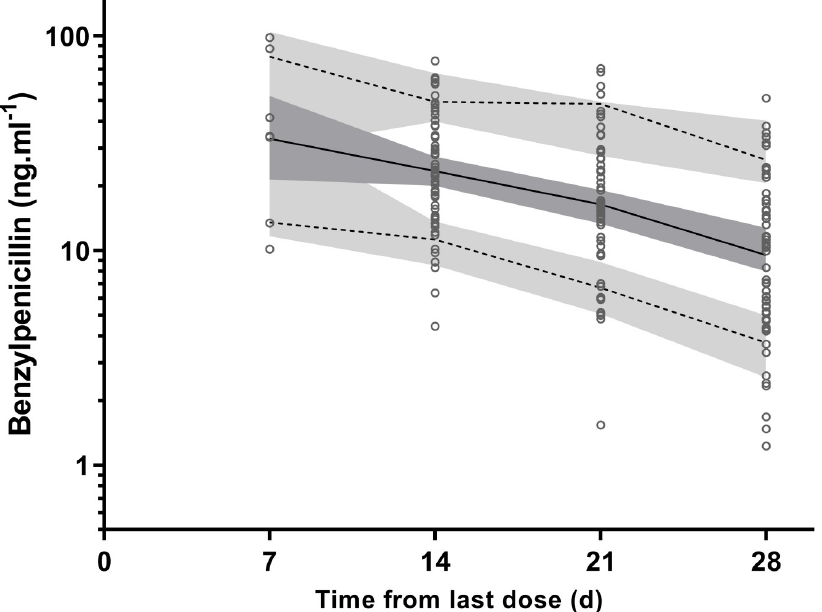
Fig 2. Visual predictive checks for plasma penicillin G concentrations (ng.mL -1 on log 10 scale). Observed 50th (solid line), and 10th and 90th (dotted lines) percentiles within their simulated 95% confidence intervals (grey shaded areas) are shown with overlying the data points ( �